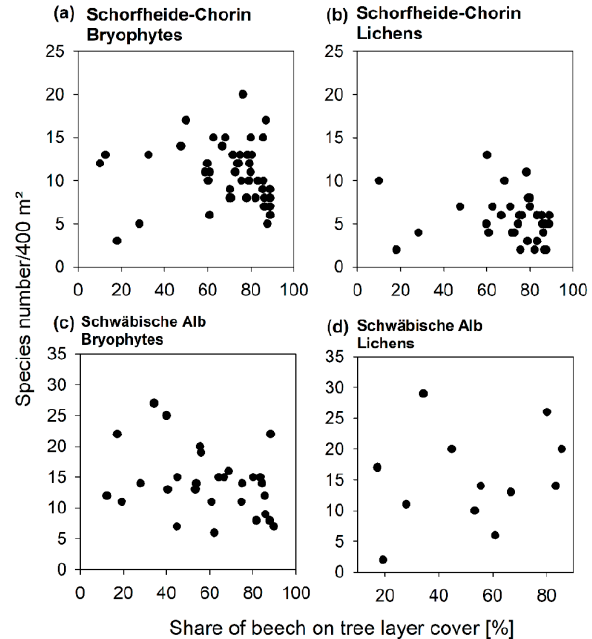
Figure A4. Gamma diversity ( a – c : species richness; d-f: Shannon diversity) for threatened and protected ( a , d ) vascular plant species, ( b , e ) bryophyte species and ( c , f ) lichen species in Schwäbische Alb along compositional gradients of pure beech (Be), pure spruce (Spr) and mixed stands (Mix). The composition of stand types was varied in steps of 10% using 1000 resamplings of 17 (vascular plants) and 26 (bryophytes) plots per step or 66 resamplings of 10 plots per step (lichens). Labelled dots mark the maximum (orange) and minimum (light blue) gamma diversity.